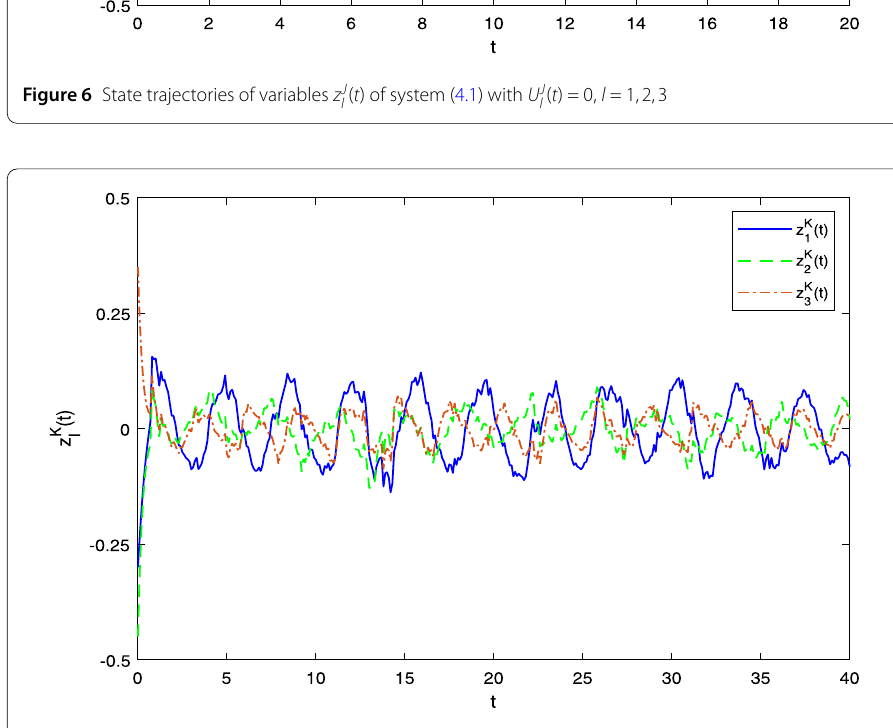
Figure 7 State trajectories of variables z K